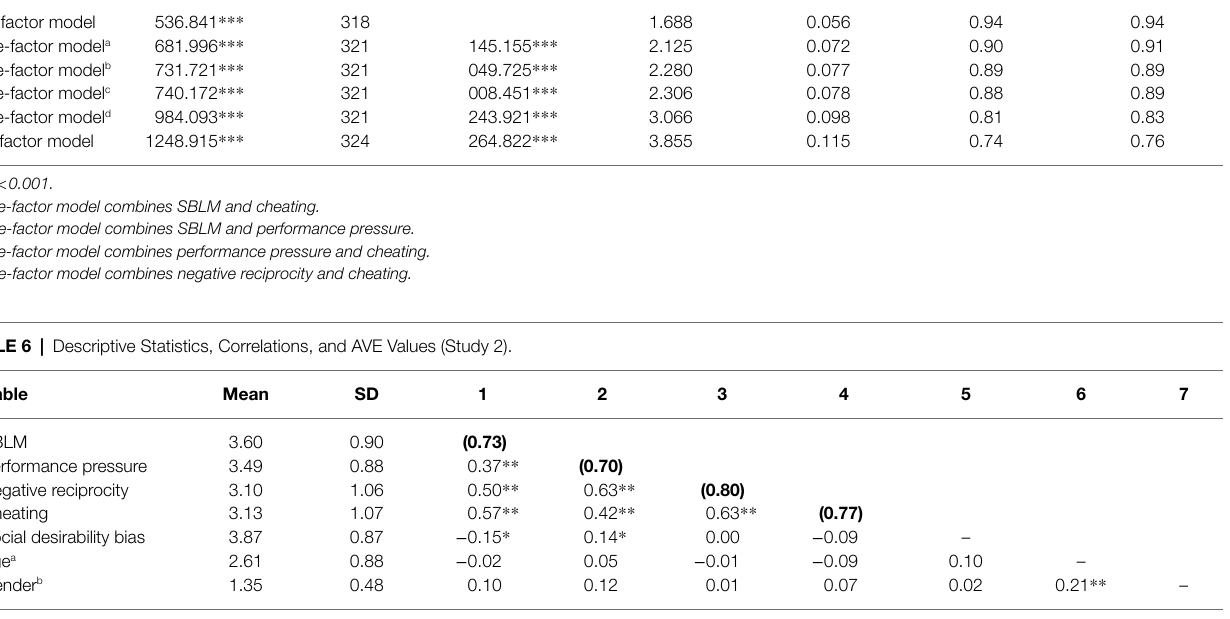
TABLE 5 | Measurement model comparisons (Study 2). Model